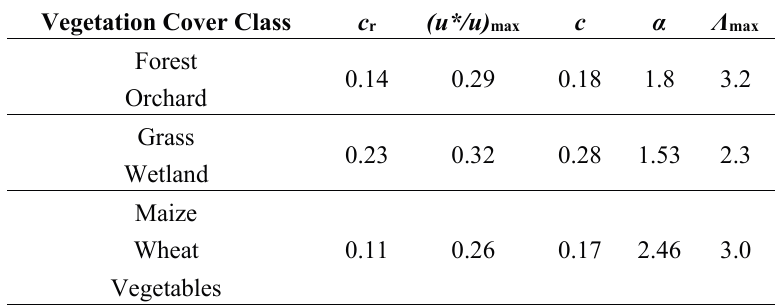
Table 4. Parameters applied in the R92 model for the study area of Heihe River Basin for 2012 (adapted from